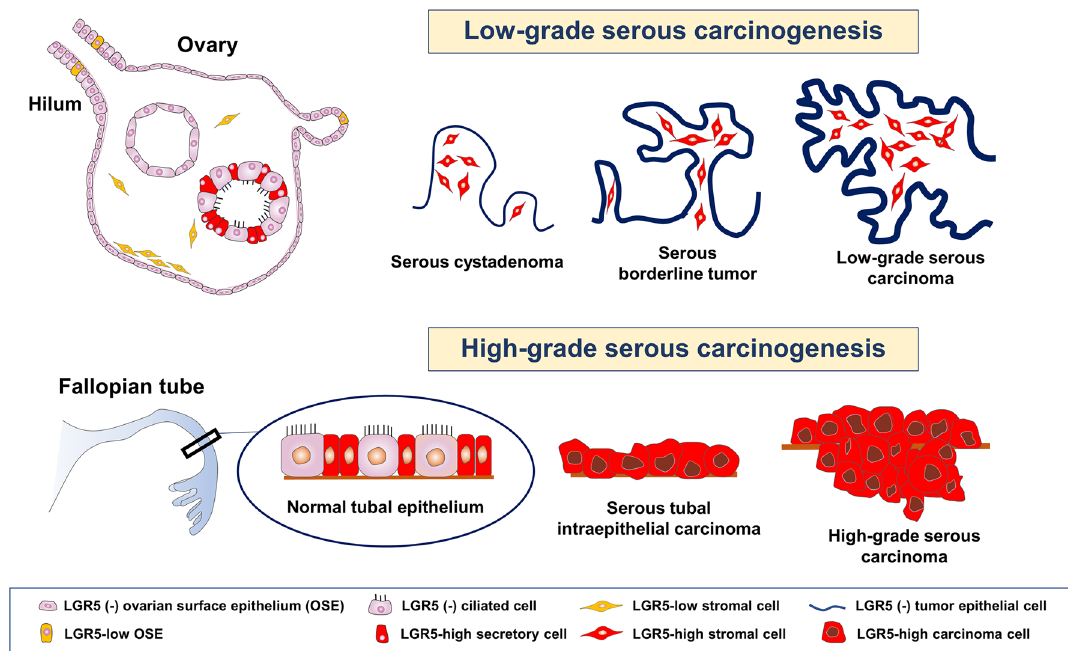
Figure 10. Schematic representation of distribution of LGR5 expression in ovary, fallopian tube, and ovarian serous